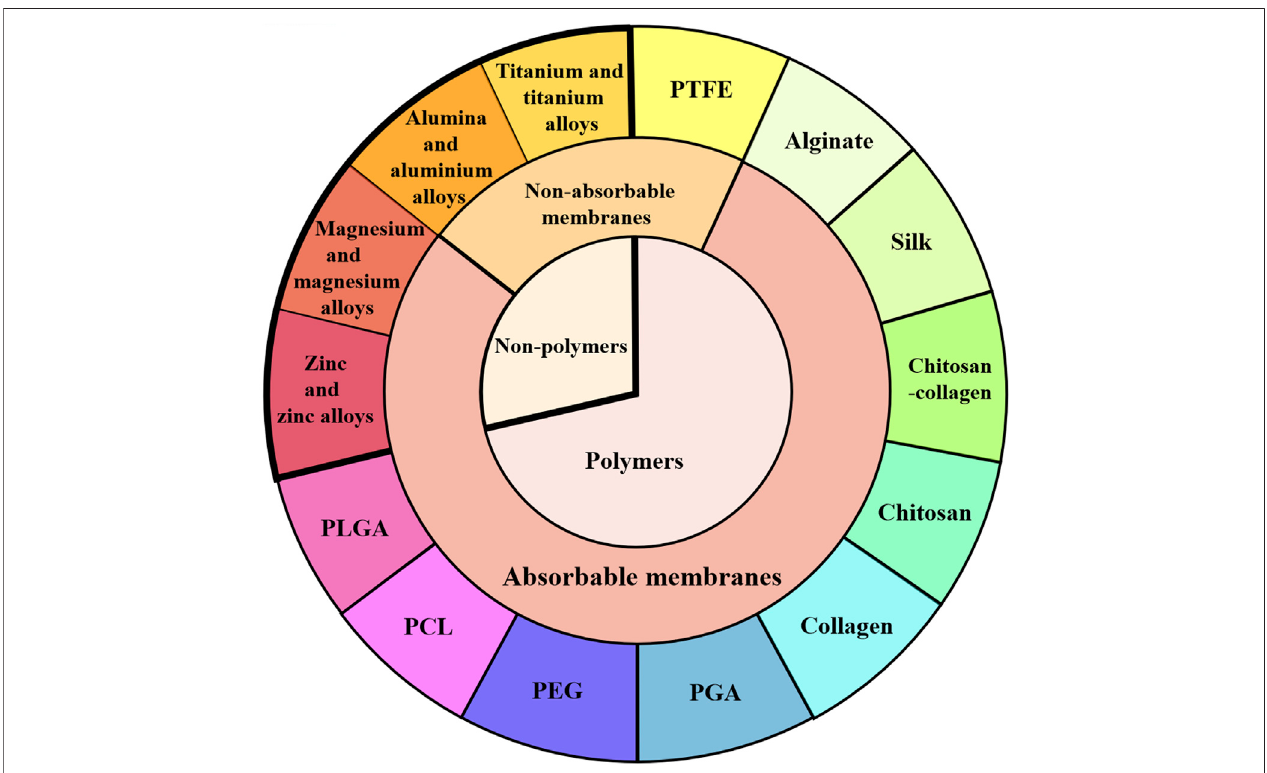
FIGURE 3 | Classi fi cation of barrier membranes. GBR barrier membranes are classi fi ed from polymer and non-polymer, absorbable and non-absorbable barrier membranes. Several typical barrier membranes in each classi fi cation are introduced in the text of this paper.